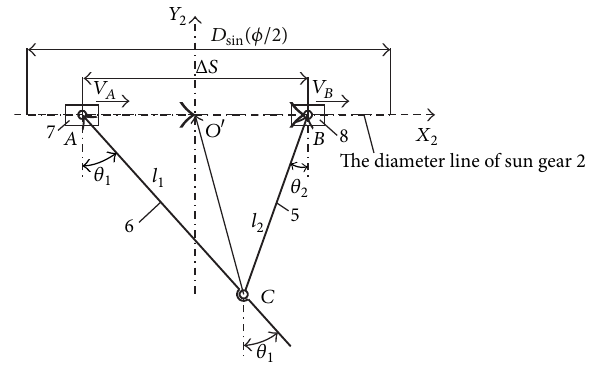
Figure 4: The working mechanism of the equivalent mechanism.